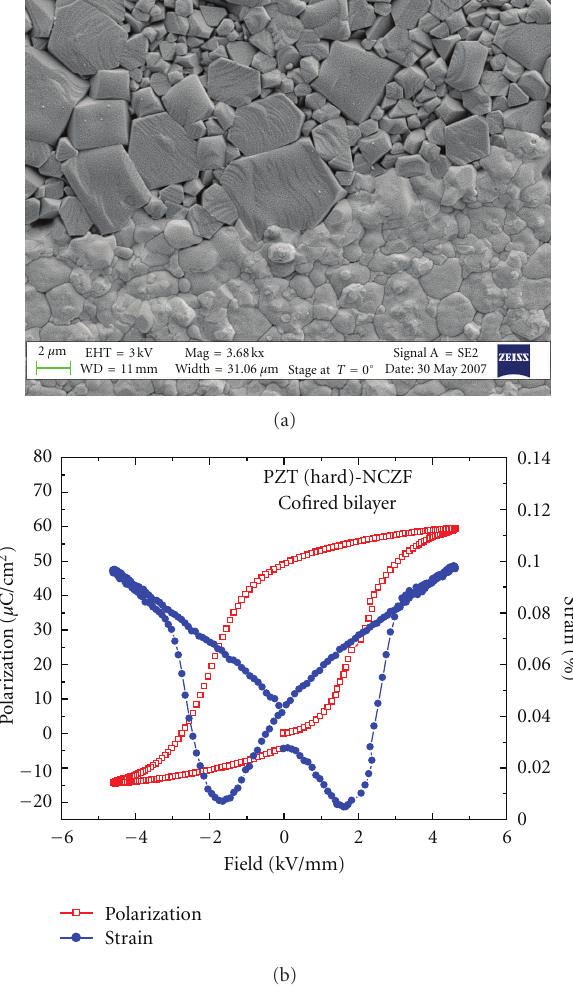
Figure 9: SEM images of PZT (hard)-NCZF bilayer composite and its magnetoelectric